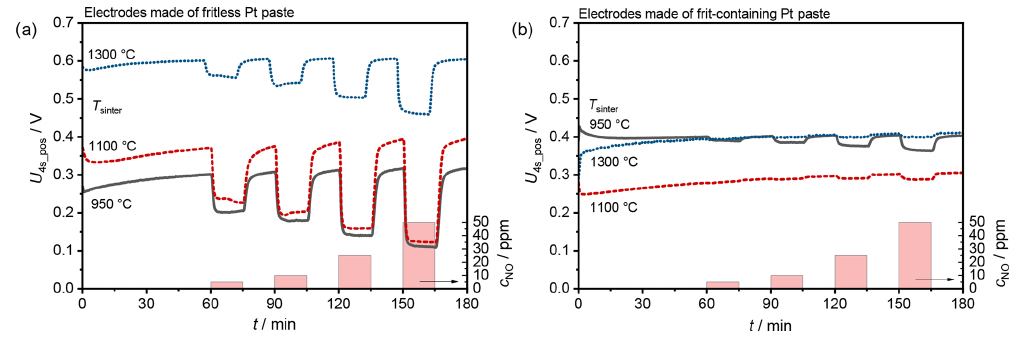
Figure 3. Sensor signal of the sensors (a) with fritless and (b) with frit-containing Pt paste.